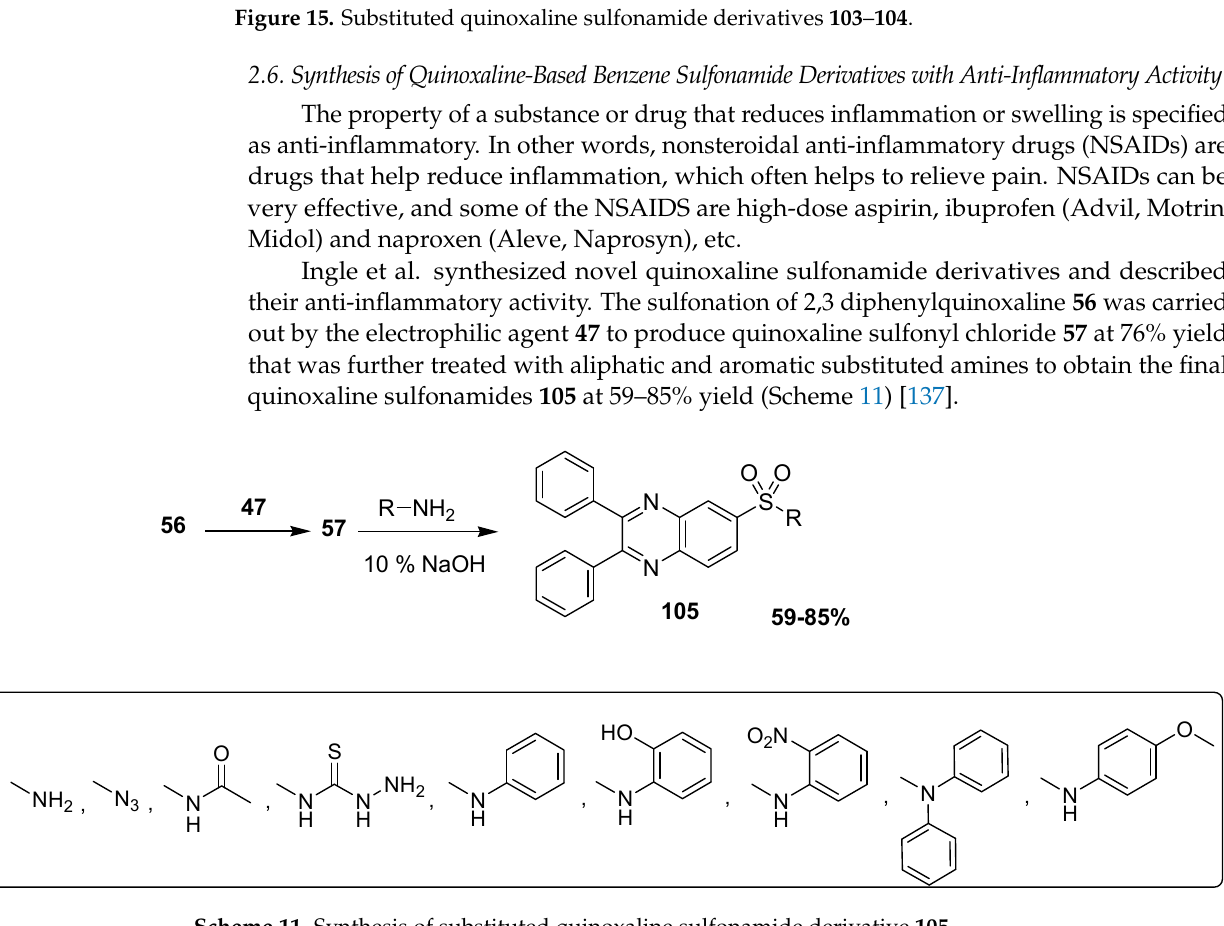
Scheme 11. Synthesis of substituted quinoxaline sulfonamide derivative 105